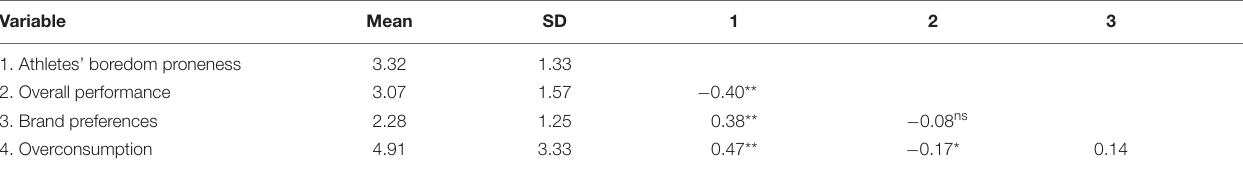
TABLE 1 | Descriptive statistics and correlations.